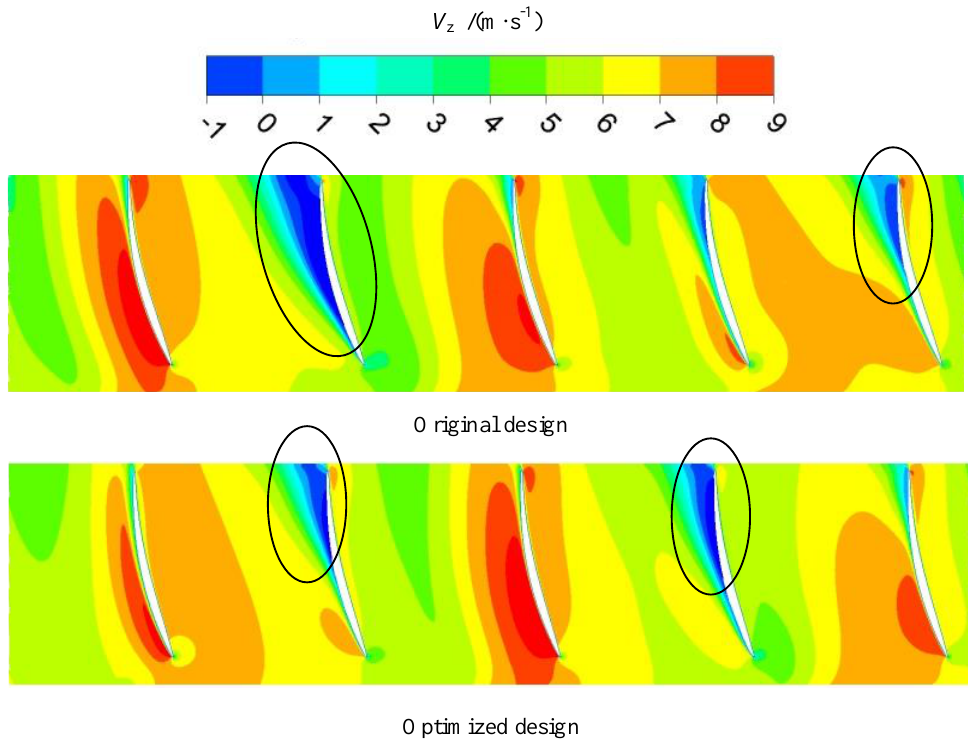
Figure 15. Comparison of the velocity axial distribution in the diffuser between the original and optimized design under the forward design flow rate (span = 0.5).